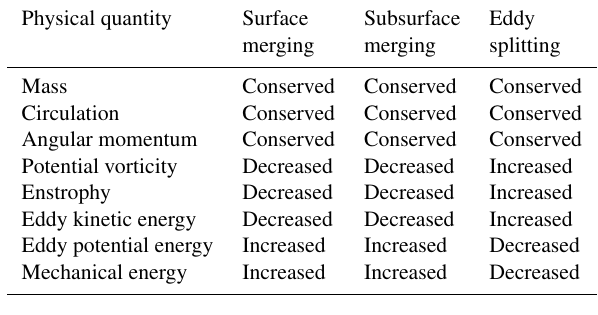
Table 1. Observed physical quantity changes after merging events and conjectured changes after splitting events.